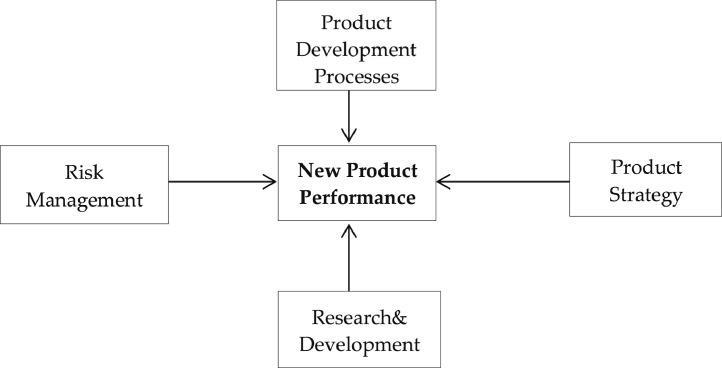
Research framework.